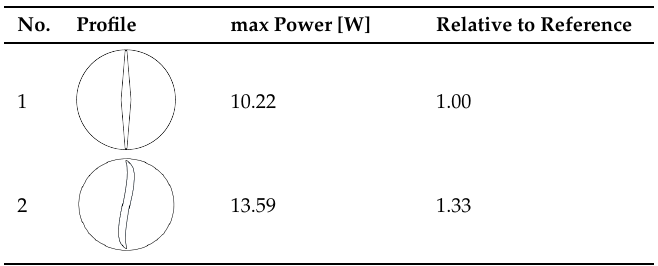
Table 5. Airfoils in comparison in the simulated laboratory channel with free water surface: Original (1); and final optimization (2).